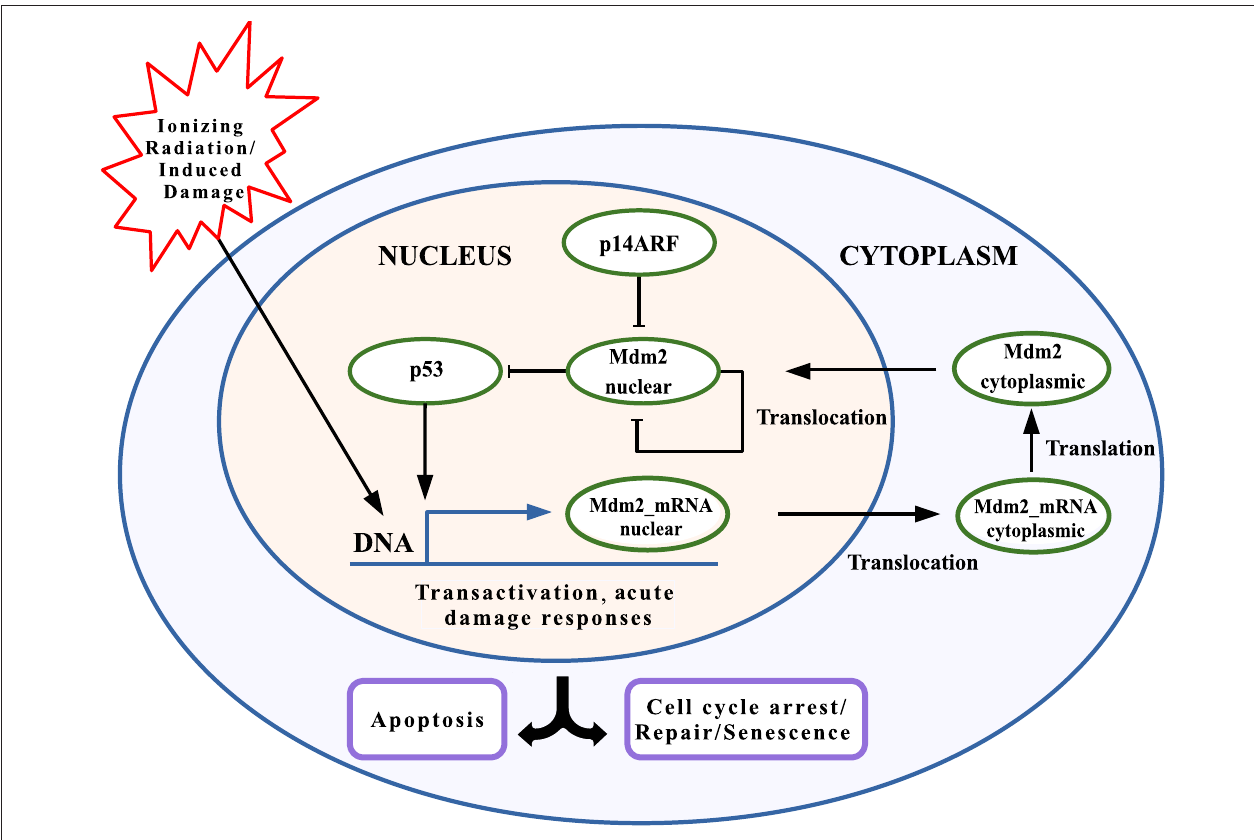
FIGURE 1 | Schematic model of p53 network including Mdm2 nuclear inhibition by p14ARF. p53 stabilization leads to transcriptional activity, inducing Mdm2 mRNA expression. Mdm2 cytoplasmic is transported to the nucleus. p14ARF is also upregulated under genotoxic stress, where binds to Mdm2 nuclear and causing its suppression. p53 downstreaming possible responses include cell cycle arrest, DNA repair, senescence, and/or apoptosis.